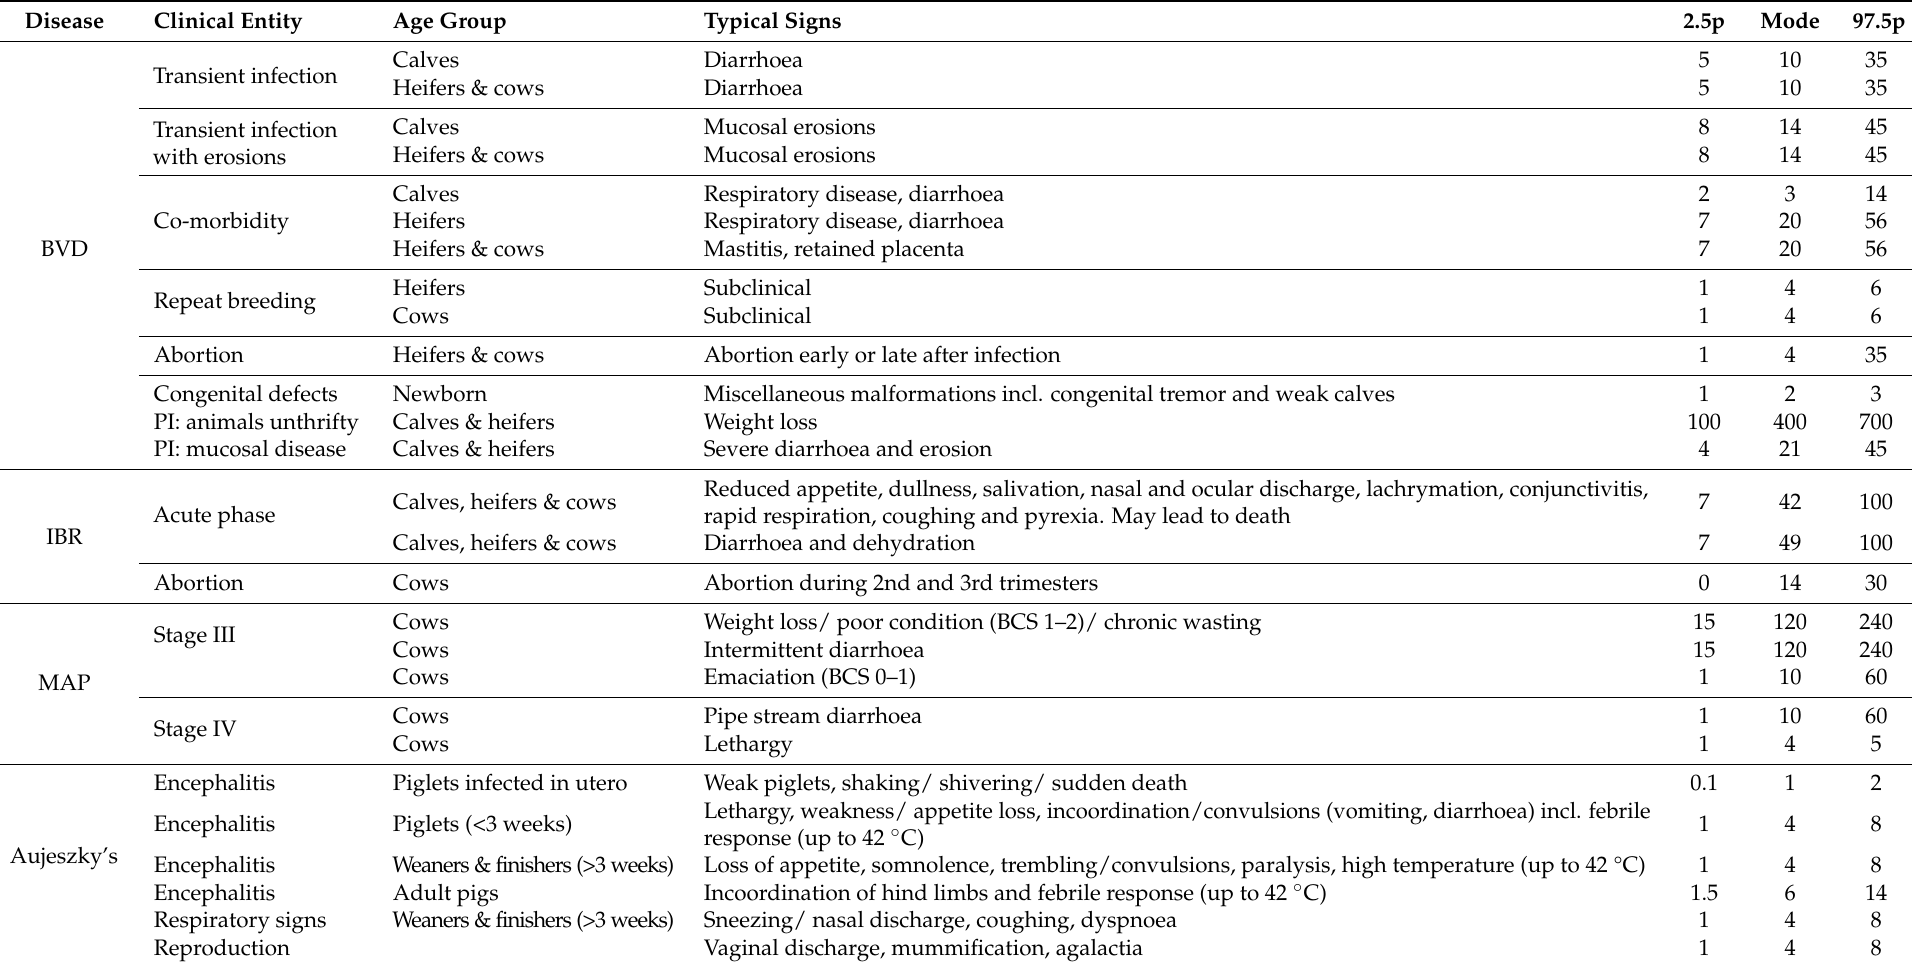
Table 3. Distribution (mode and 2.5/97.5 percentiles (p)) of the duration (days) of clinical entities based on literature and expert knowledge elicitation for the five diseases 1 and ten non-infectious welfare